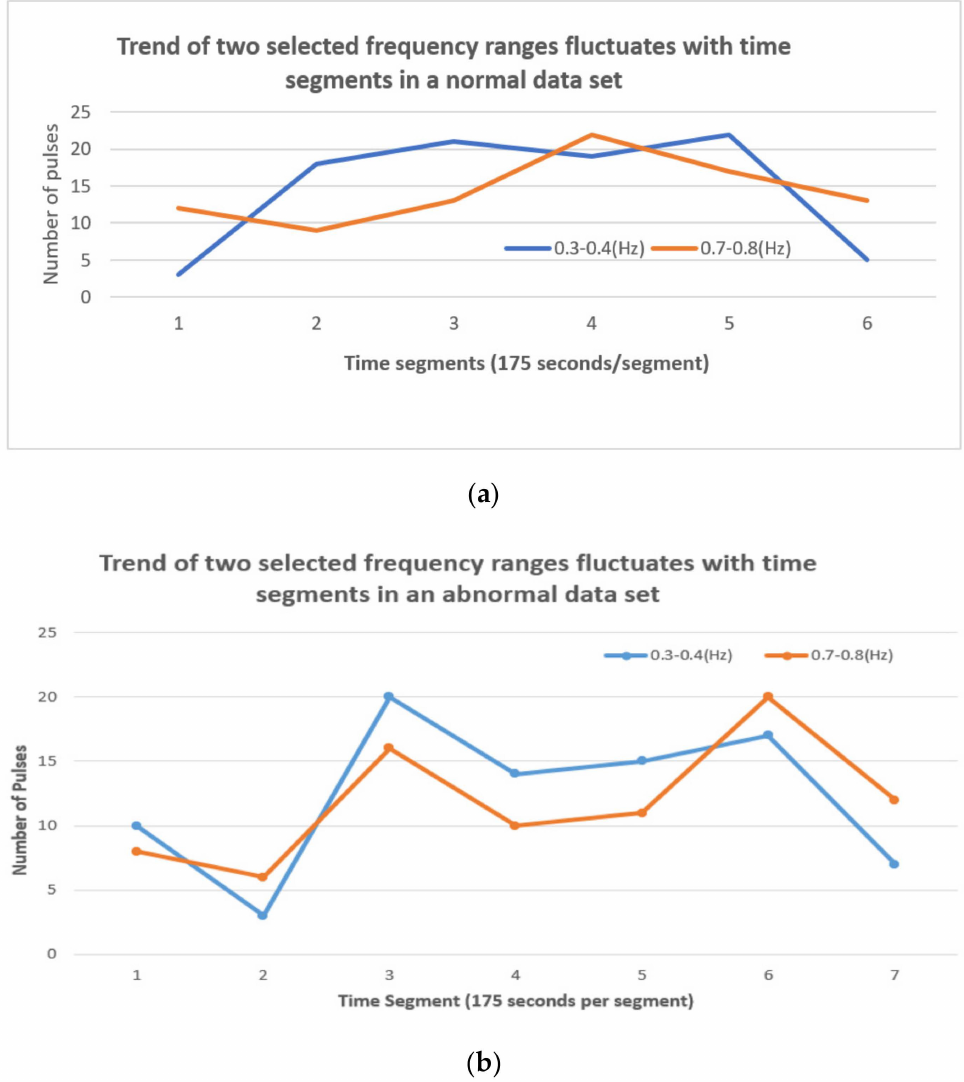
Figure 11. Trend of two selected frequency ranges fluctuates with time segments in two data sets: ( a ) number of pulses in the two dominant frequency ranges along time segments in a normal data set, ( b ) number of pulses in the two dominant frequency ranges along time segments in an abnormal data